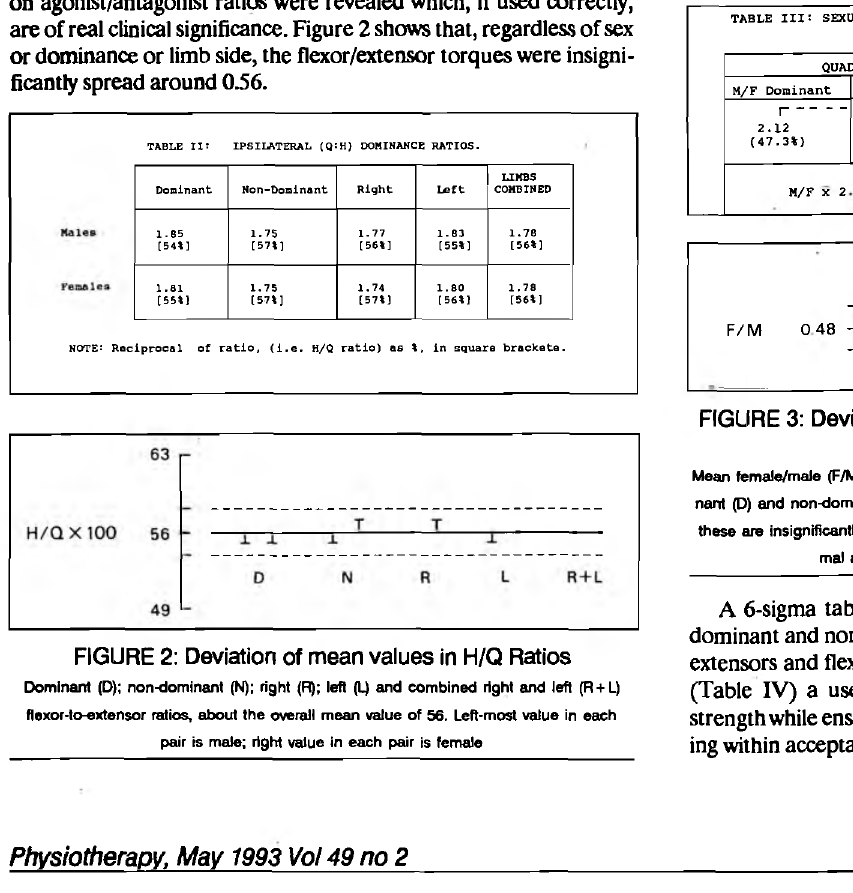
TABLE Ills SEXUAL DIMORPHISM (Reciprocal in Brackets)